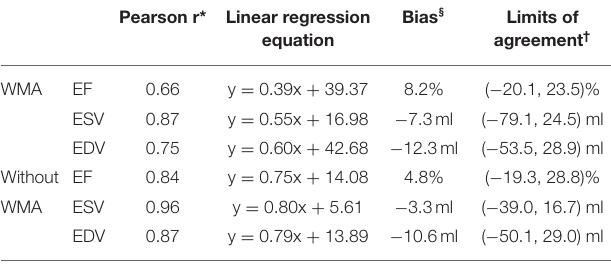
TABLE 6 | Correlation and agreement analysis for 2DTTE and CMR in patients with and without regional wall motion abnormality. Pearson r* Linear regression